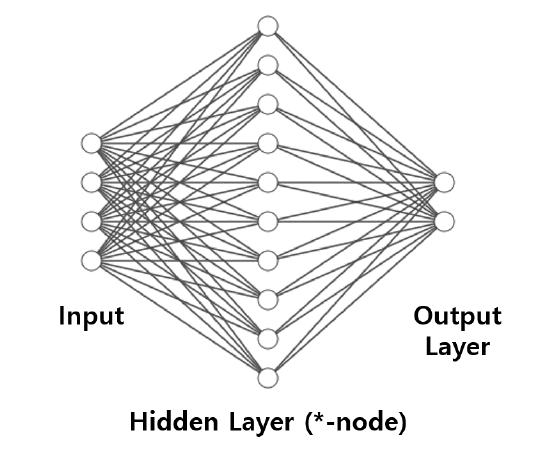
Figure 2. The architecture of neural